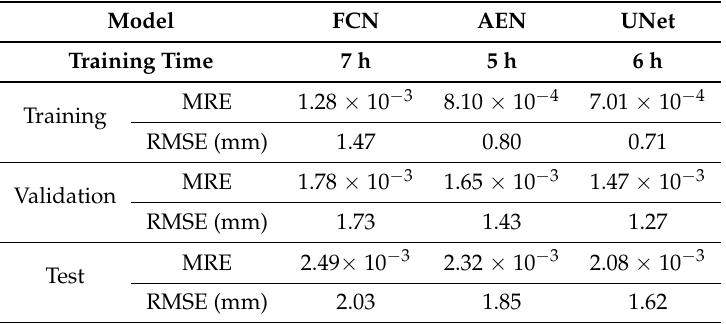
Table 1. Performance evaluation of the CNNs.